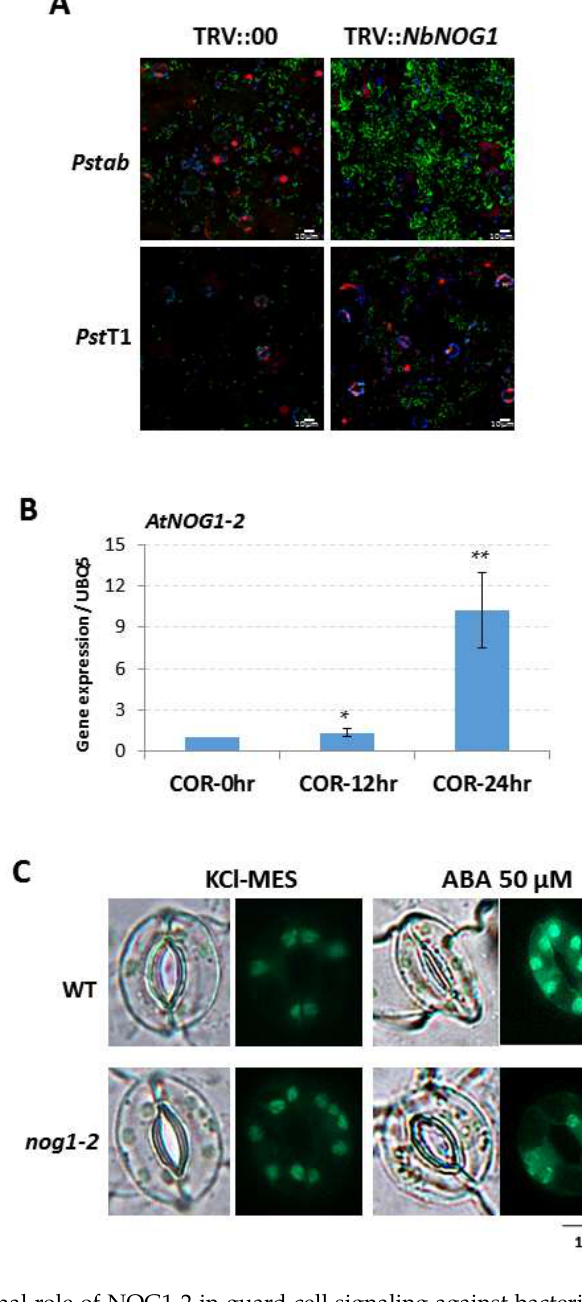
Figure 1. Functional role of NOG1-2 in guard cell signaling against bacterial pathogens and ABA. Epidermal peels from silenced- N. benthamiana plants (TRV:: NbNOG1 ) and from non-silenced controls TRV::00 were incubated with the host pathogen P . syringae pv. tabaci ( Pstab ; 1×10 6 CFU/mL) expressing pDSK-GFP uv [15] or the non-adapted pathogen P . syringae pv. tomato T1 ( Pst ; 1×10 6 CFU/mL) expressing pDSK-GFP uv [15]. ( A ) Bacterial entry through stomata was observed by laser scanning confocal microscopy after 3 h of inoculation. Green: bacterial pathogens ( Pstab or Pst T1) expressing GFPuv ; Blue: auto-fluorescence of chloroplast; Red: nuclei. ( B ) NOG1-2 expression was determined